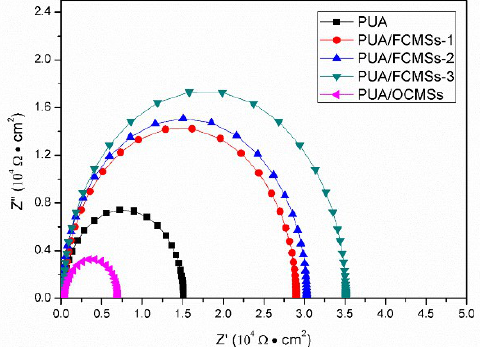
Figure 14. Nyquist plots of UV-curable polyurethane composite coatings.